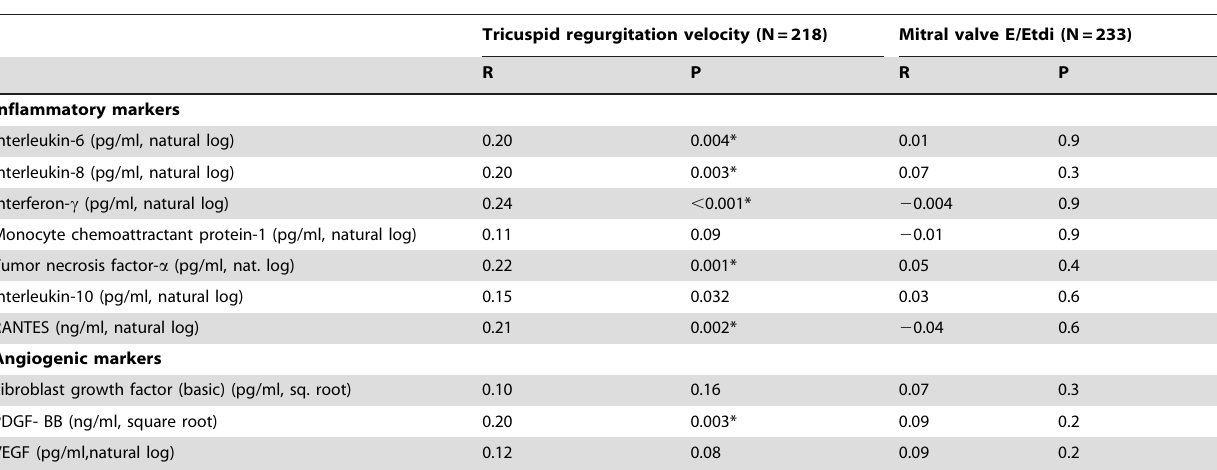
Table 3. Bivariate relationships of biologic markers with cardiopulmonary outcomes in patients with sickle cell disease.